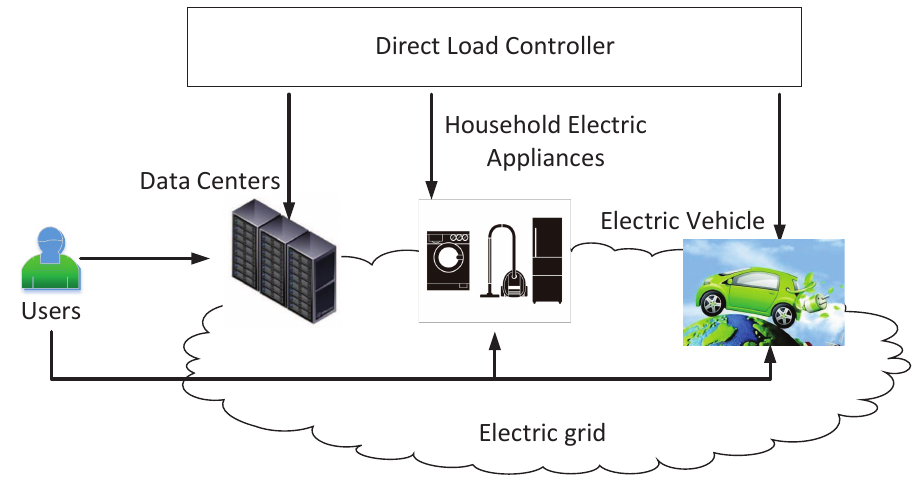
Figure 4. The model of the direct load